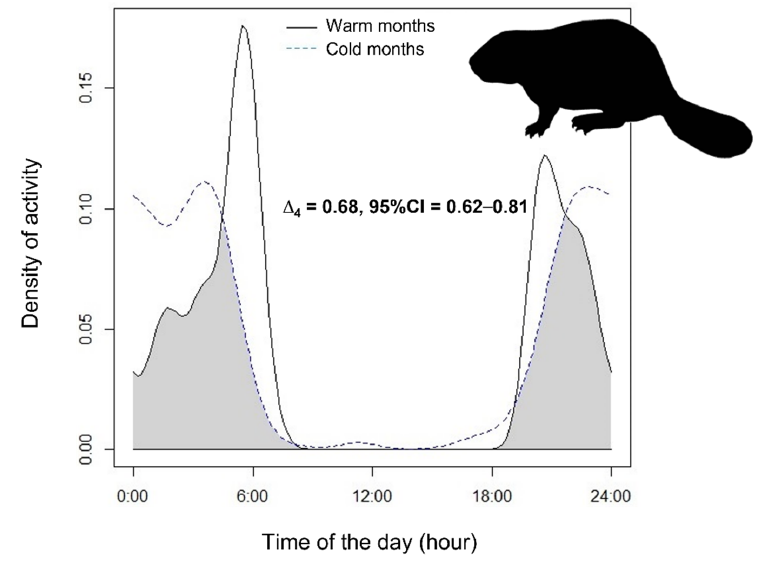
Figure 3. Interseasonal overlap of activity patterns expressed as kernel density estimates (coefficient Δ 4 ) of the Eurasian beaver in Central Italy; 95% CI = 95% Confidence Intervals.